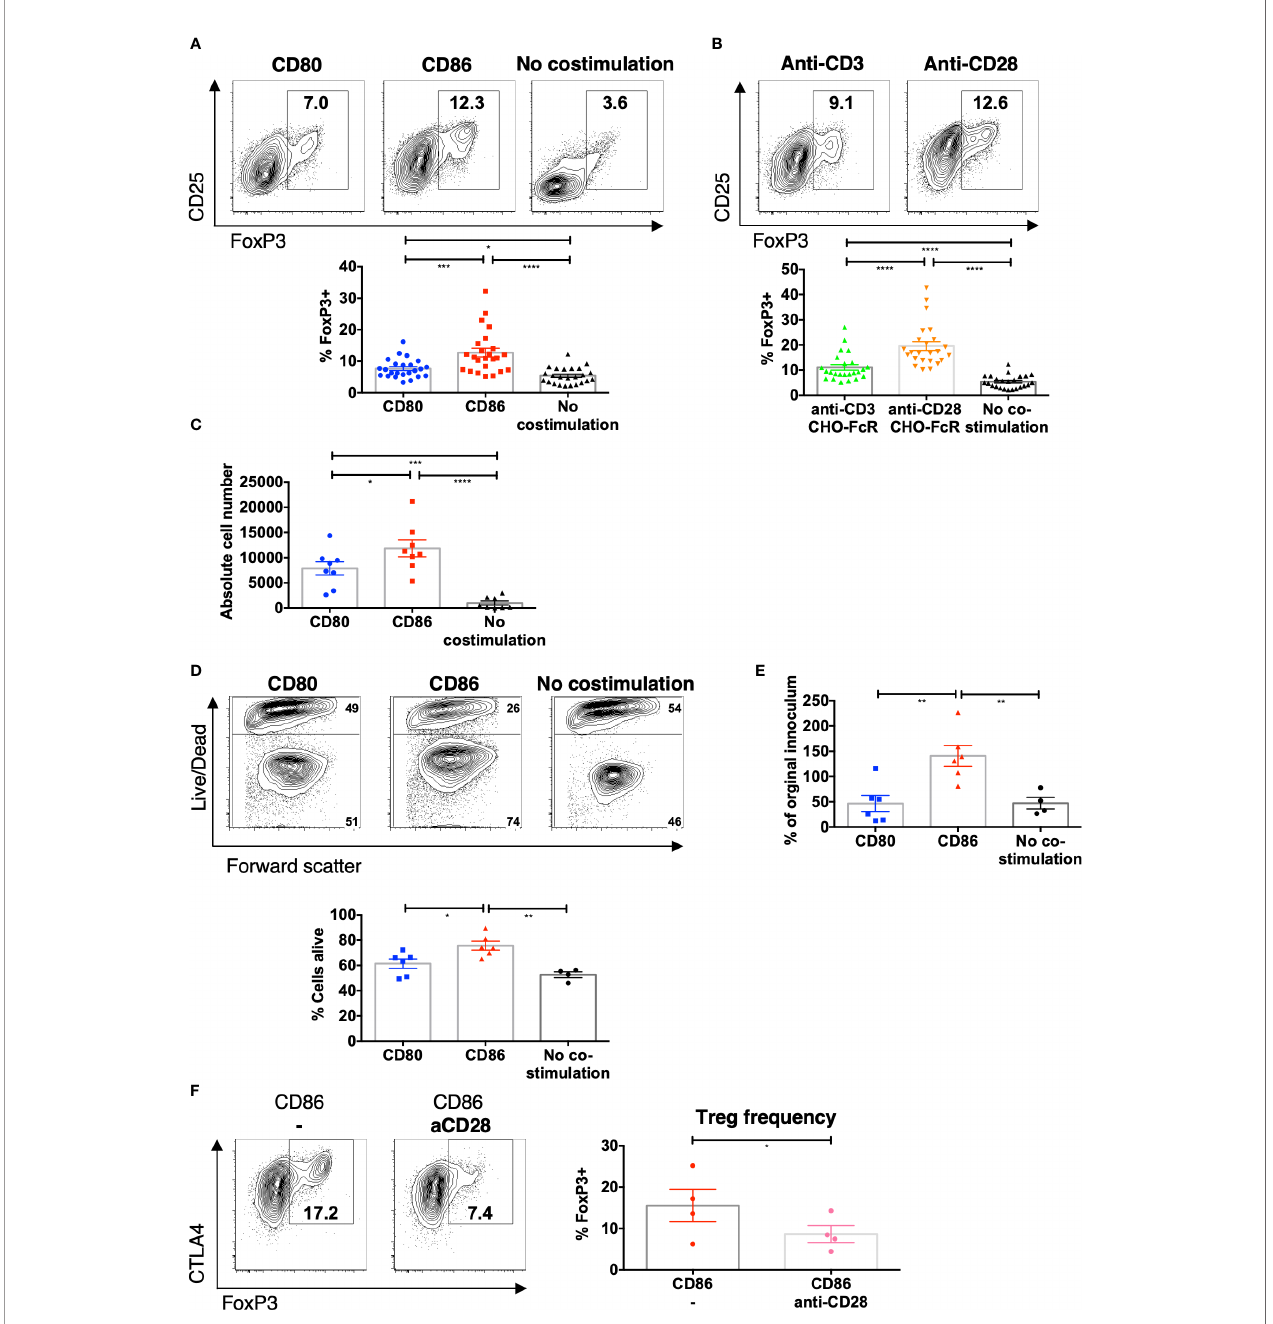
FIGURE 2 | CD86-CD28 interactions drive accumulation of Treg. CTV labelled total memory CD4 T cells isolated from healthy donors were cultured for 5 days with (A) CHO-CD80, CHO-CD86 or untransduced CHO (no costimulation), at a ratio of 10 T cells to one CHO cell, with 0.5 m g/ml anti-human-CD3 or B) CHO-FcR at 2.5:1 ratio with 1 m g/ml anti-human-CD3 or anti-human-CD28. (A, B) Frequency of FoxP3+ amongst divided T cells (24 independent experiments). (C) absolute number of FoxP3+ cells after stimulation (under same conditions as A) (eight independent experiments). Puri fi ed Treg isolated from healthy donors were cultured with CHO-CD80, CHO-CD86 or untransduced CHO cells, at 10:1 ratio for 5 days, with 0.5 m g/ml anti-human-CD3 with 12.5 IU/ml IL2. (D) Representative fl ow cytometry plots demonstrate greater viability of Treg after 5 days with CD86. (E) shows the total number of Treg as a % of the starting population (six independent experiments). (F) CTV labeled total memory CD4 T cells isolated from healthy donors were cultured for 5 days with CHO-CD86 at 10:1 ratio with 0.5 m g/ml anti- human-CD3 and 1 m g/ml anti-human-CD28. Representative plots and graph demonstrate reduced frequency of FoxP3+ cells amongst divided T cells with blockade of CD28 (four independent experiments). One-way ANOVA with Tukey ’ s multiple comparisons tests (A – D) and paired t-test (E) : *p ≤ 0.05, **p ≤ 0.01, ***p ≤ 0.001, ****p ≤